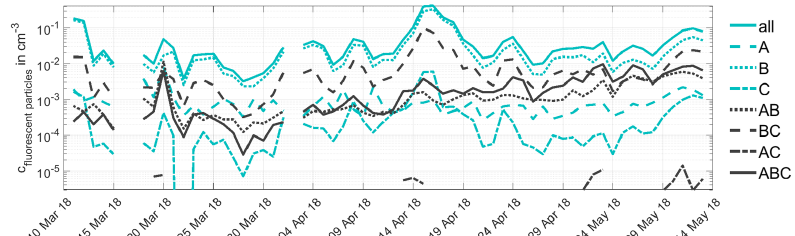
Figure A2. Time series of fluorescent particle number concentrations. The number concentrations of fluorescent particles measured by WIBS in different excitation emission wavelength pair combinations (fluorescence groups) are shown from 11 March to 13 May 2018. The definition of the different fluorescence groups is based on the categorization given in Savage et al. (2017). A summary of this categorization is given in Sect. 2.3.